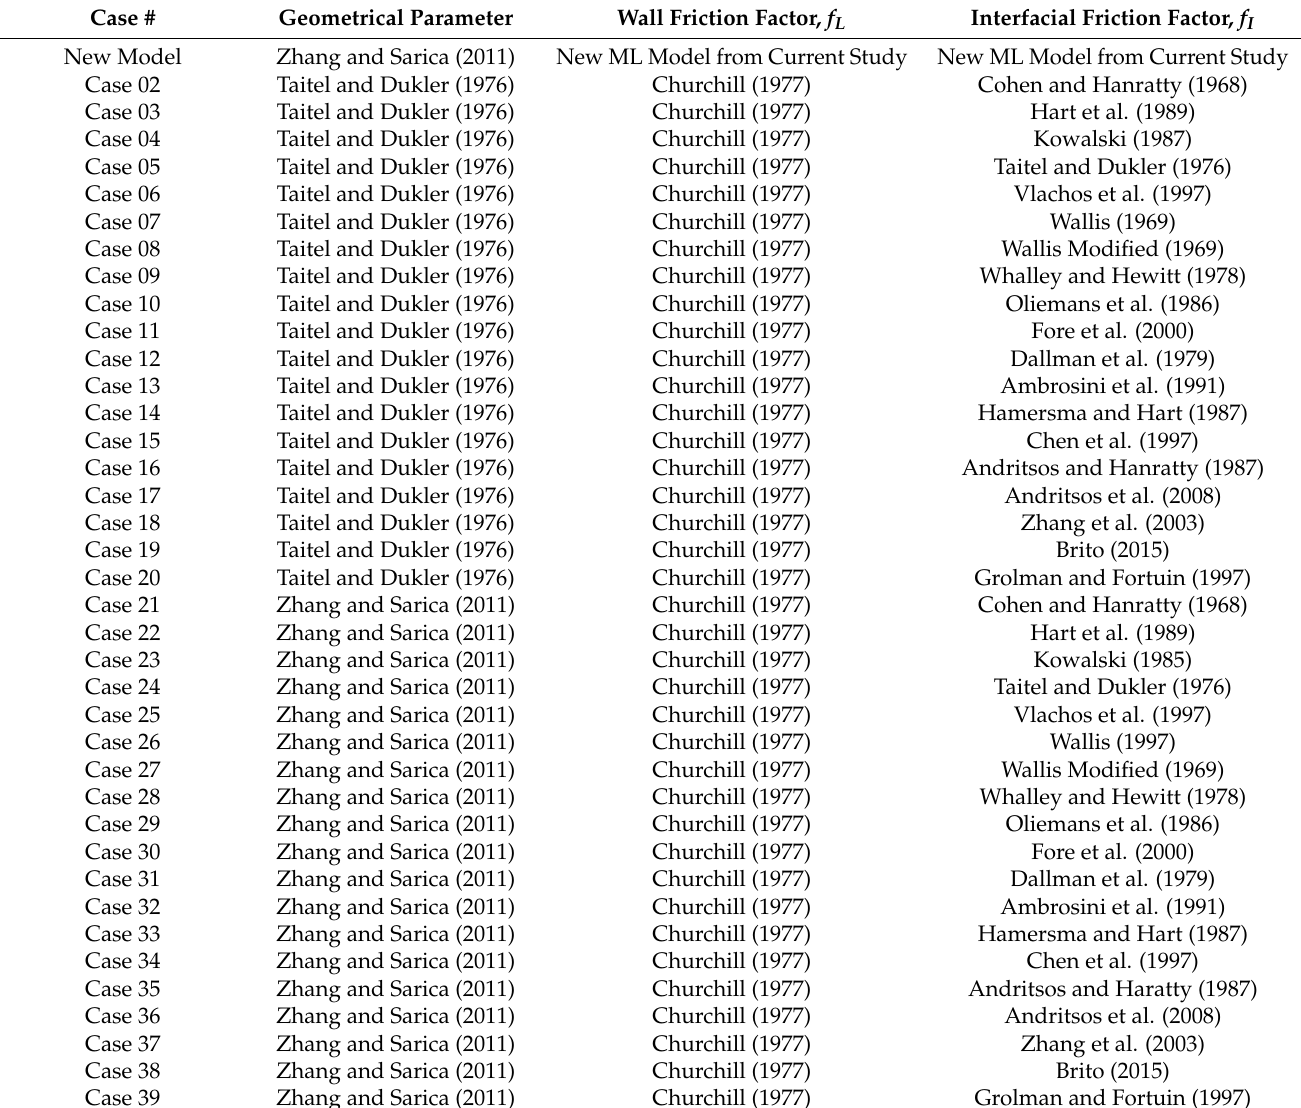
Table indicating case number and the corresponding combination of geometrical parameters, wall friction factor, and interfacial friction factor used for model validation. Table A1. Case number and the corresponding correlations used for model validation in Figures 11 and